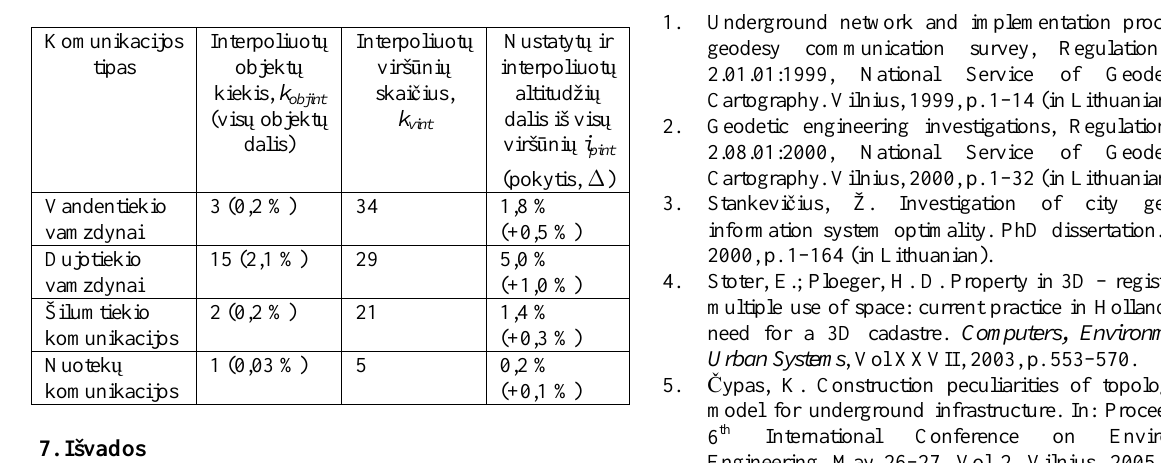
Table 4. Results of altitude interpolation to utility’s